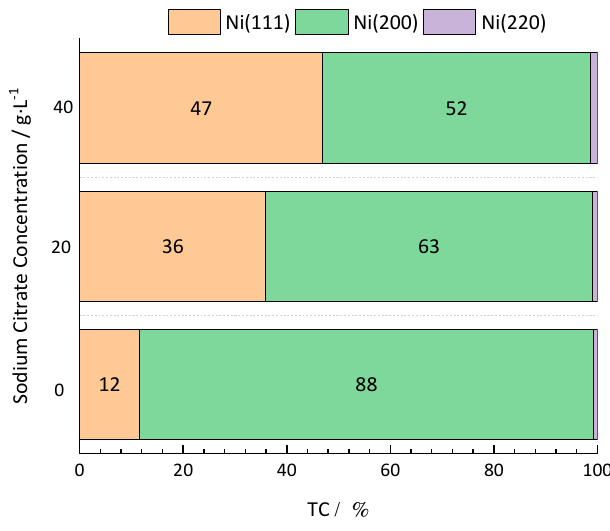
Figure 3. Effect of sodium citrate concentration on preferred orientation of coatings.